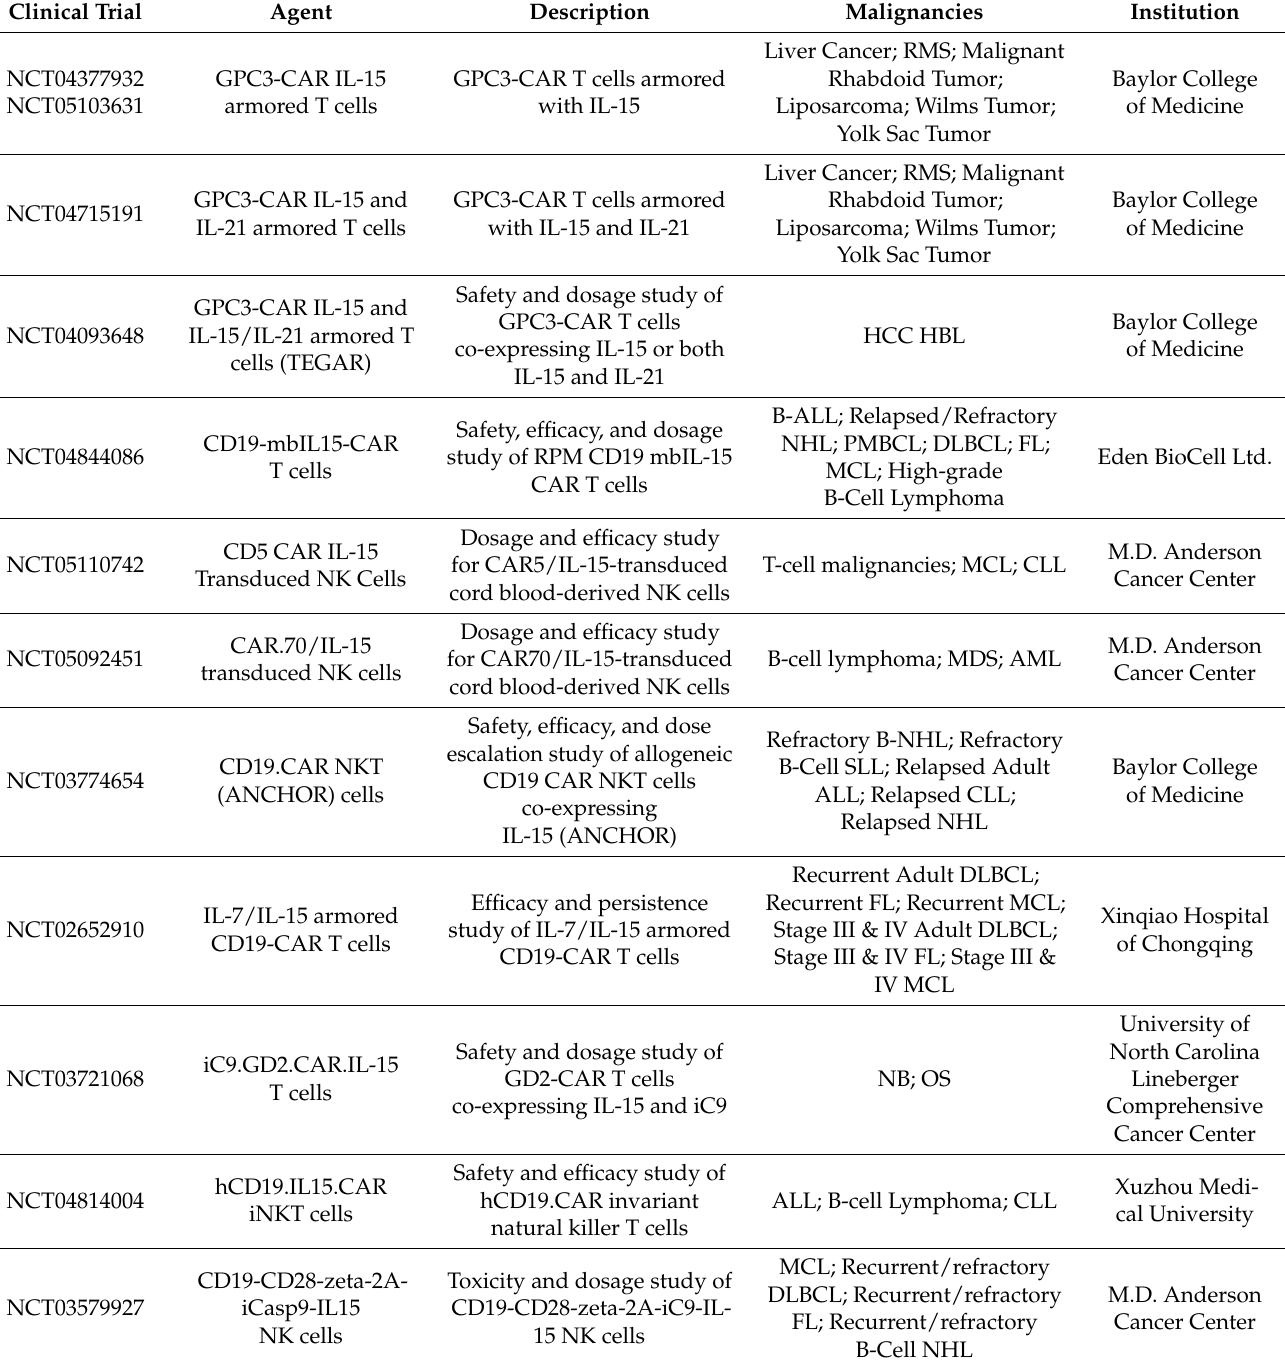
Table 4. Clinical trials of IL-15 armored cells in cancer immunotherapy. IL-21, Interleukin-21; iC9; iCaspase9; IL-7, Interleukin-7; RMS, rhabdomyosarcoma; HCC, hepatocellular carcinoma; HBL, hepatoblastoma; B-ALL, B-cell acute lymphoblastic leukemia; ALL, acute lymphocytic leukemia; NHL non-Hodgkin’s lymphoma; PMBCL, Primary mediastinal large B-cell lymphoma; DLBCL, diffuse large B-cell lymphoma; FL, follicular lymphoma; MCL, mantle cell lymphoma; SLL, small lymphocytic lymphoma; NB, neuroblastoma; OS, osteosarcoma; CLL, chronic lymphocytic